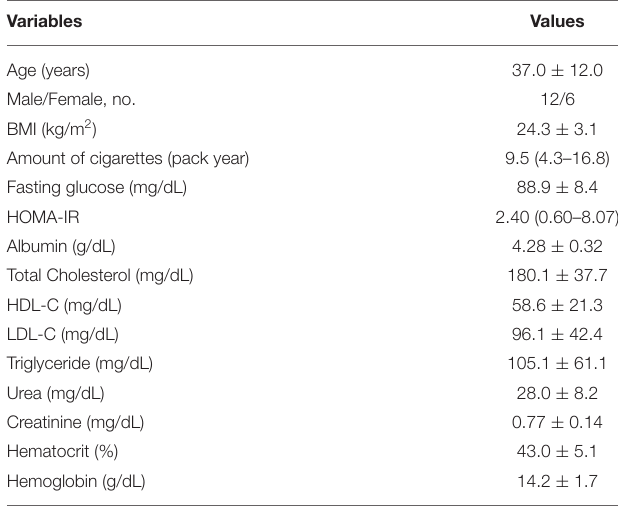
TABLE 1 | Demographic and clinical data of 18 healthy smokers included in the study.